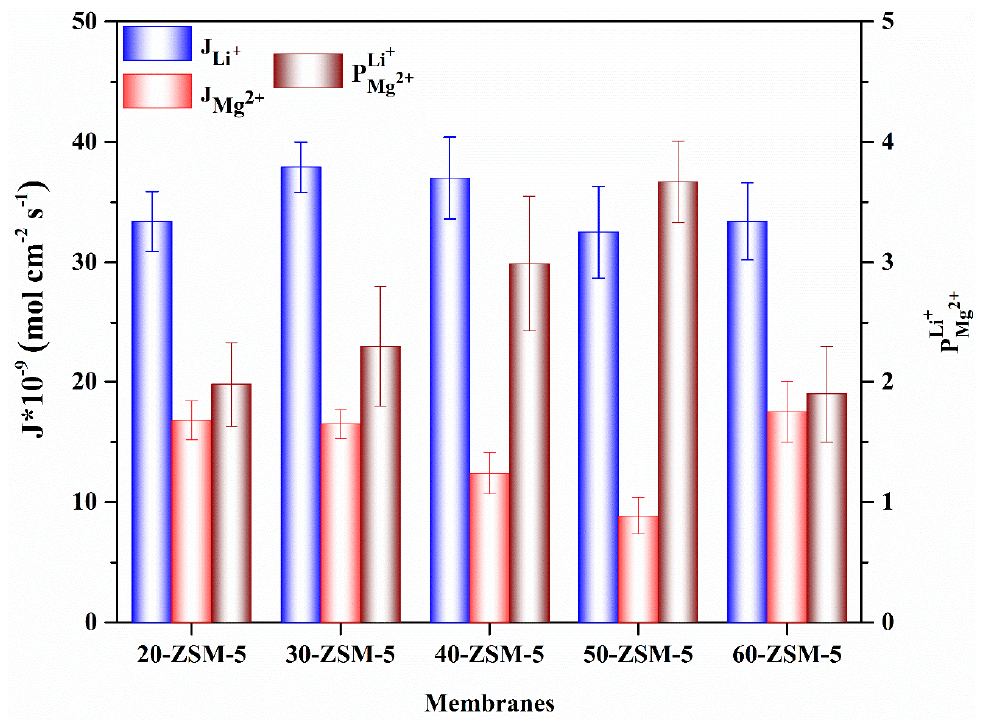
Figure 9. The ion flux and perm-selectivity of ZSM-5/PVA-based MMMs for Li + /Mg 2+ .